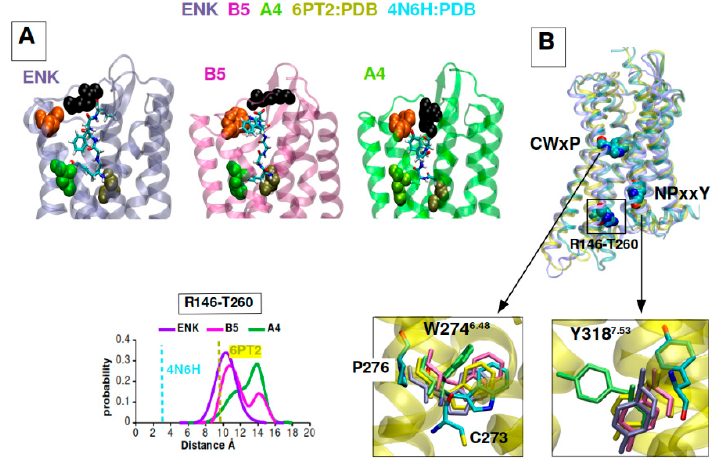
Figure 10. Computational models of GEs-DOR interactions. ( A ) Representative complexes of Leu-Enk-DOR, B5-DOR and A4-DOR extracted from simulations, showing the main contact points between peptide ligands and the receptor. ( B ) Superposition of agonist-bound crystal structure (6PT2), natrindole-bound crystal structure (4N6H) and representative structure of the Leu-enkephalin simulation, highlighting the micro-switches CWxP and NPxxY and residues 146 and 260 on TM3 and TM6 respectively. Bottom, left: distance histogram showing the distribution of distances between C α atoms of R146 and T260. Right: Close-up superposition of W274 (toggle switch) and Y318 in the inactive natrindole structure (cyan) and in simulation representative snapshots.